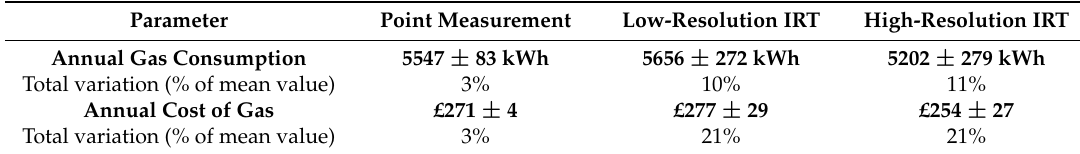
Table 5. Dynamic modelling results using U-values from point measurements, as well as low- and high-resolution